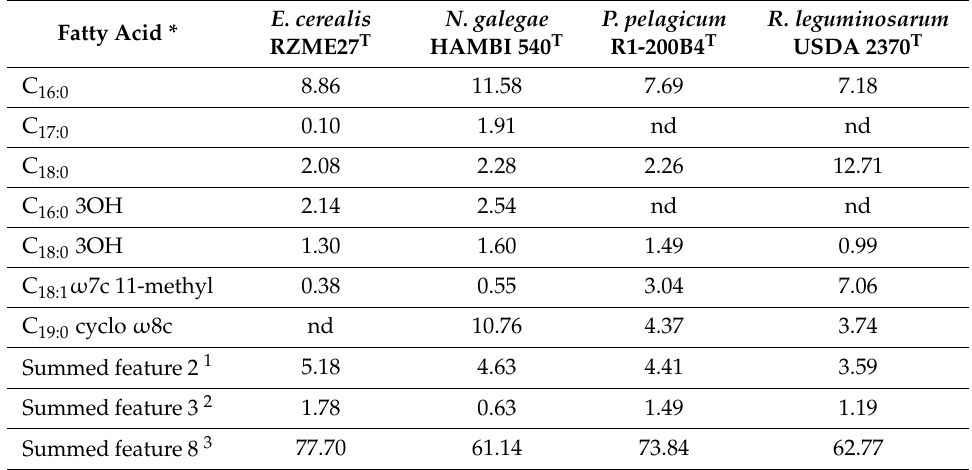
Table 3. Cellular fatty acid composition of Endobacterium cerealis , its closest related genera and the type species of the type genus of family Rhizobiaceae